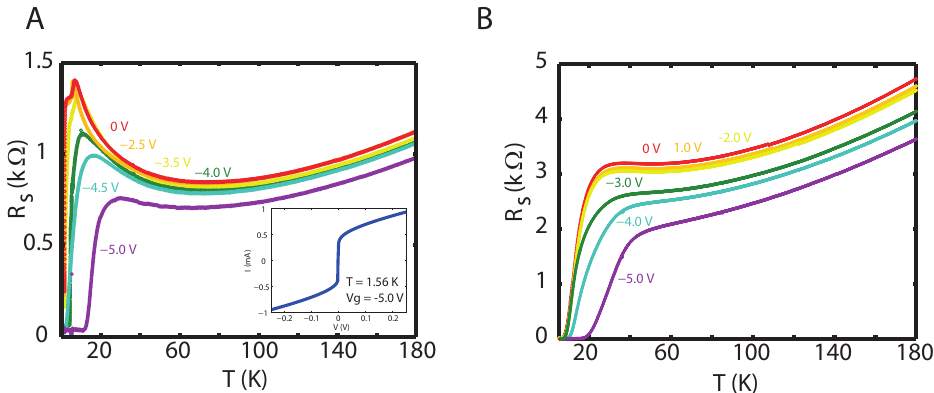
Figure 1. ( A ) Sheet resistance R S plotted against temperature T for various V g for a 30 UC thick La Sr CuO sample. At V g = 0 V, the R(T) characteristic shows that the sample is nearing 1.95 0.05 4 superconductivity at the lowest T of 1.6 K. This pattern persists for V g down to V g = − 3.5 V. Applying a lower V g leads to the emergence of superconductivity with T c growing to 12.0 K when V g = − 5 V is applied. The inset shows the source-drain current as a function of the voltage over two side contacts at T = 1.6 K and V g = − 5 V; ( B ) Similar data for a thinner sample of 10 UCs, where the superconducting state is extended in T c only for V g below − 3